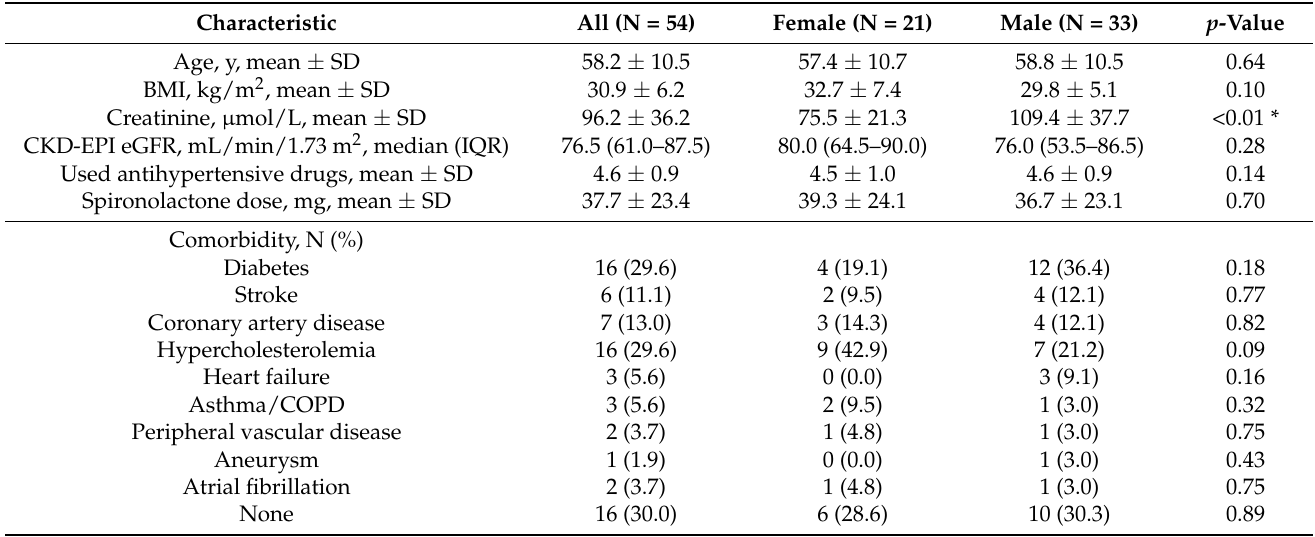
Table 1. Baseline characteristics patients from RHYME-RCT trial using